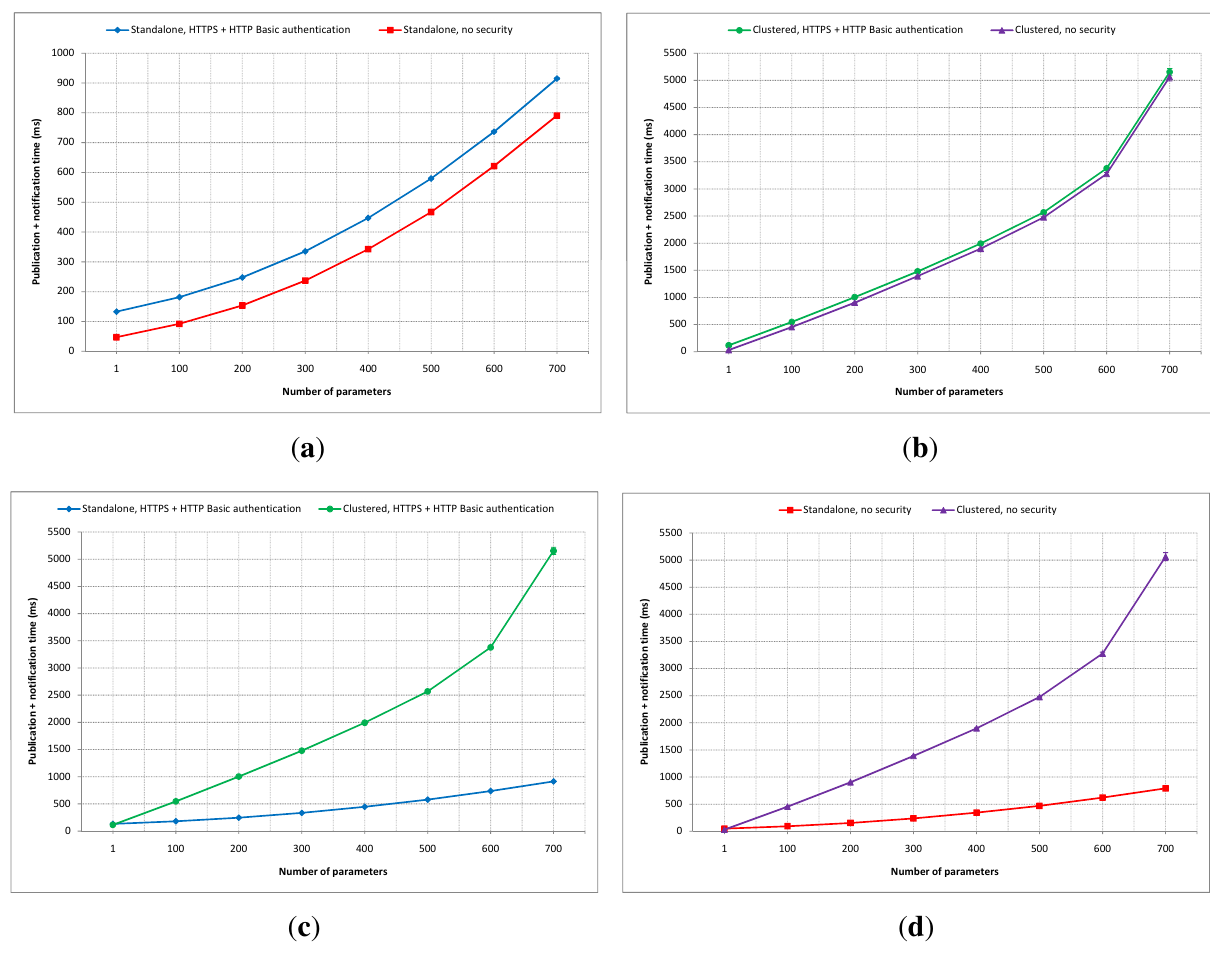
Figure 19. Publication and notification time comparisons with the number of parameters as the variable: ( a ) Standalone secure vs . insecure; ( b ) Clustered secure vs . insecure; ( c ) Secure standalone vs . Clustered; ( d ) Insecure standalone vs .